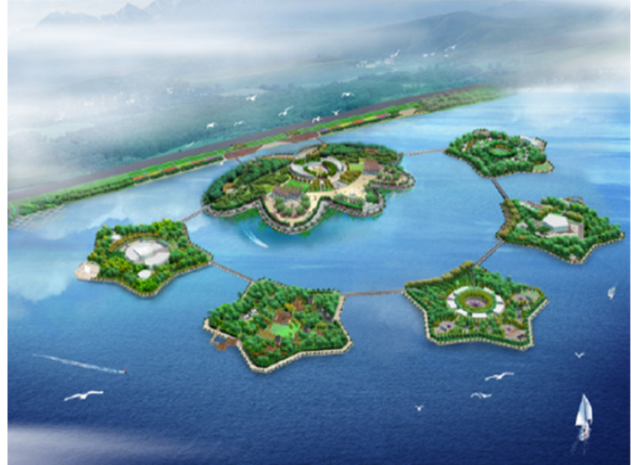
Figure 14. Artificial lake and islands by rubber dams.